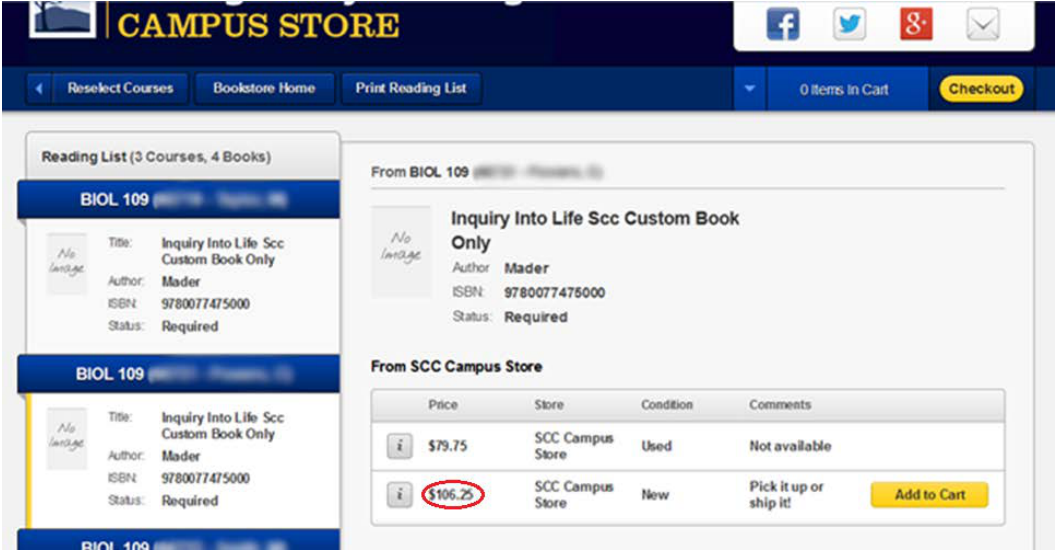
Figure 1 . Example of finding textbook cost by